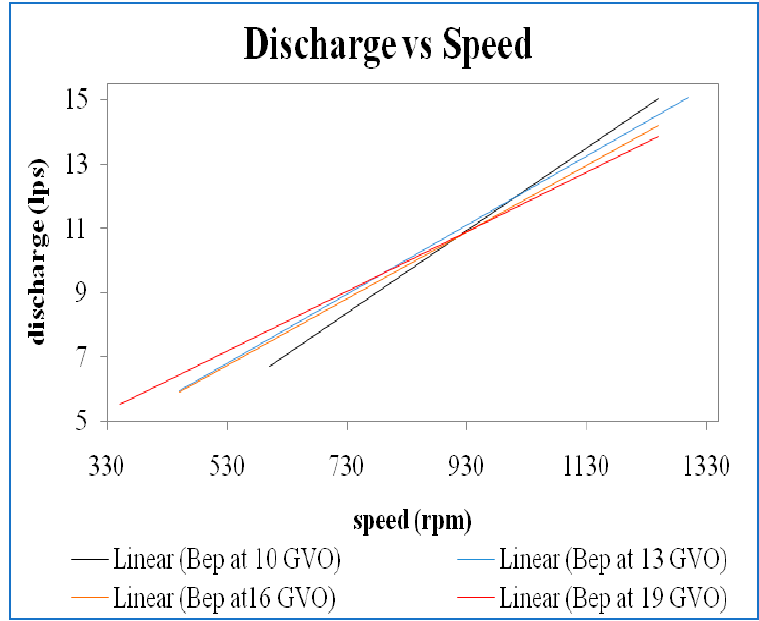
Figure 24. Discharge vs. speed for best efficiency point at 10 mm GVO.